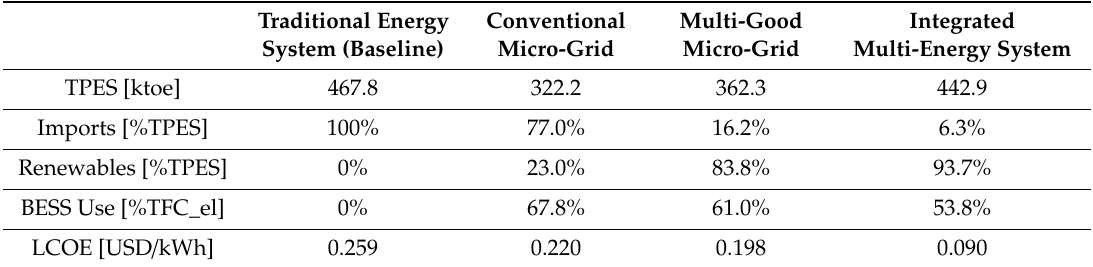
Table 2. Summary of selected indicators for the four proposed scenarios.